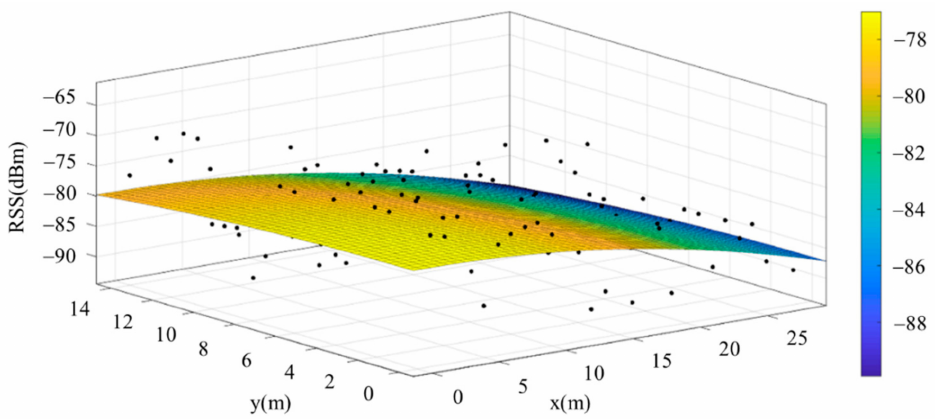
Figure 16. Fitting Model for Same Base Station Using Data Collected Facing East.